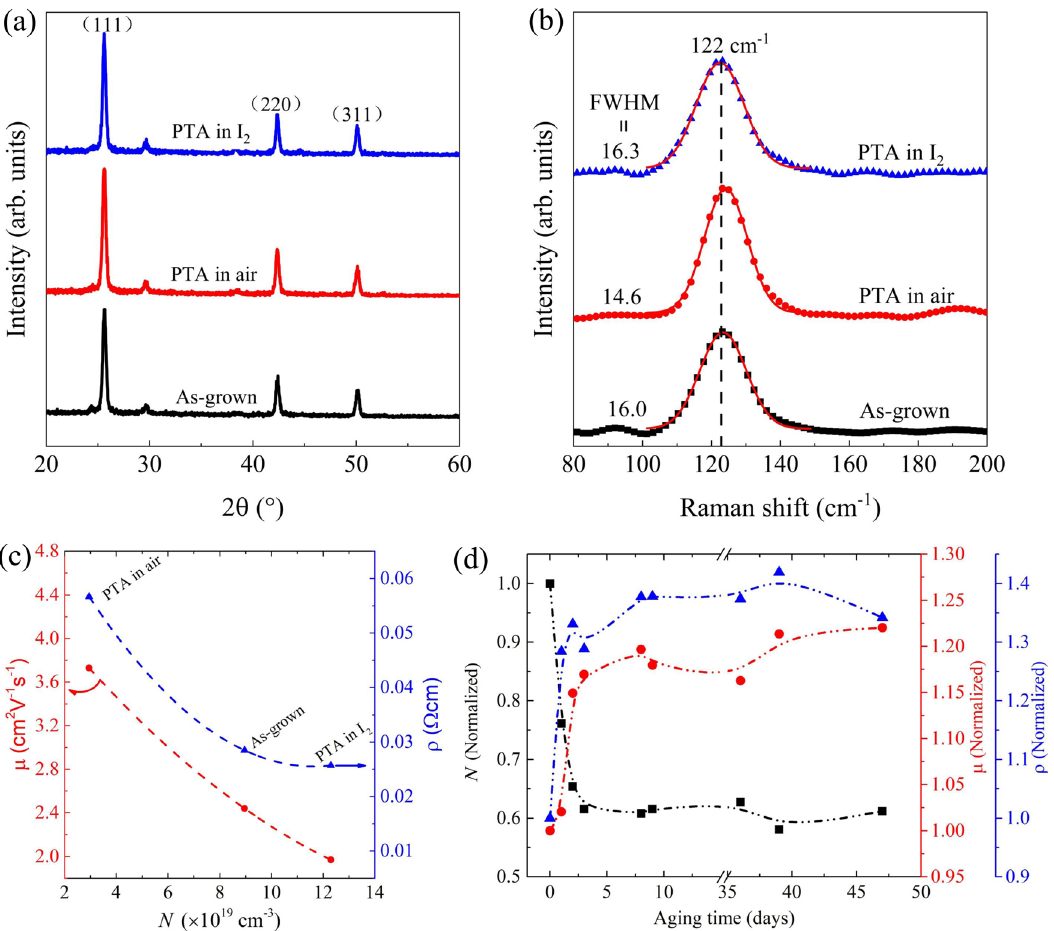
Fig.1|Structuralandelectricalproperties. GIXRDspectra( a )andRamanspectra ( b ) of CuI thin fi lms with different treatments, namely, as-grown (black), PTA in air (red),andPTAiniodinevapors(blue).Theredlinesin b arethecorrespondingpeak fi ts. c ElectricalpropertiesofCuIthin fi lmswithdifferenttreatments(i.e.,as-grown,